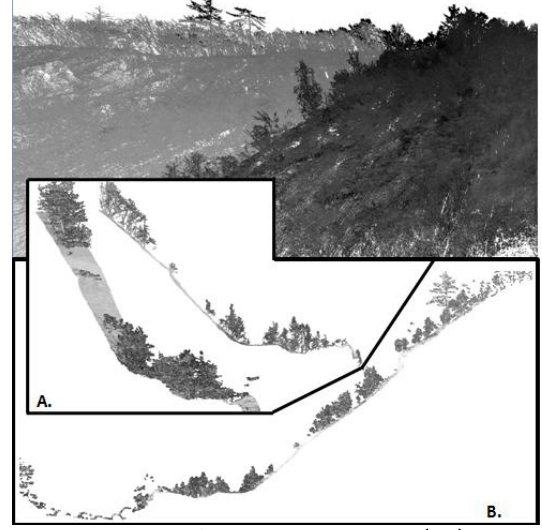
Figure 2. 3D view of the acquired point data (top).